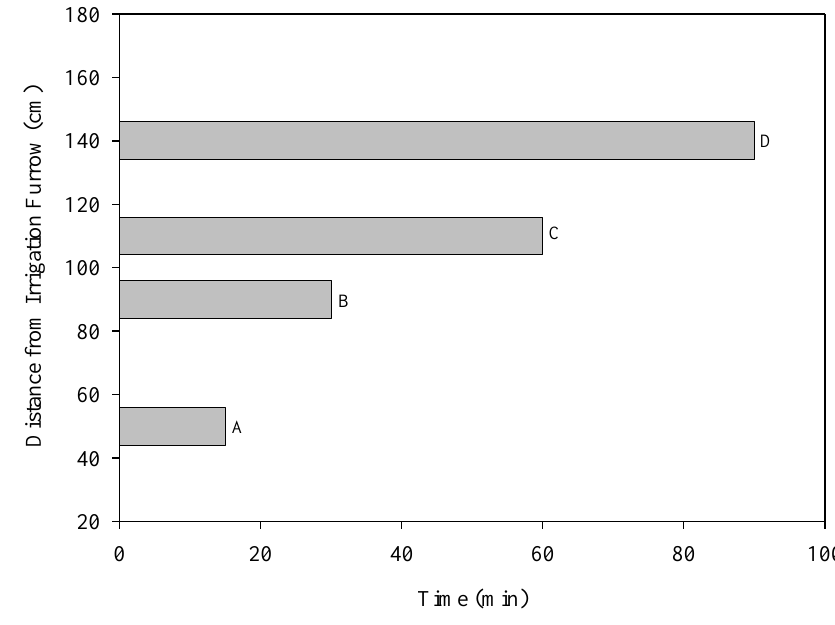
FIGURE 1. Permeating velocity of irrigated water at 20-cm depth of clay rice soil at different times: (A) 15 min, (B) 30 min, (C) 60 min, and (D) 90 min.